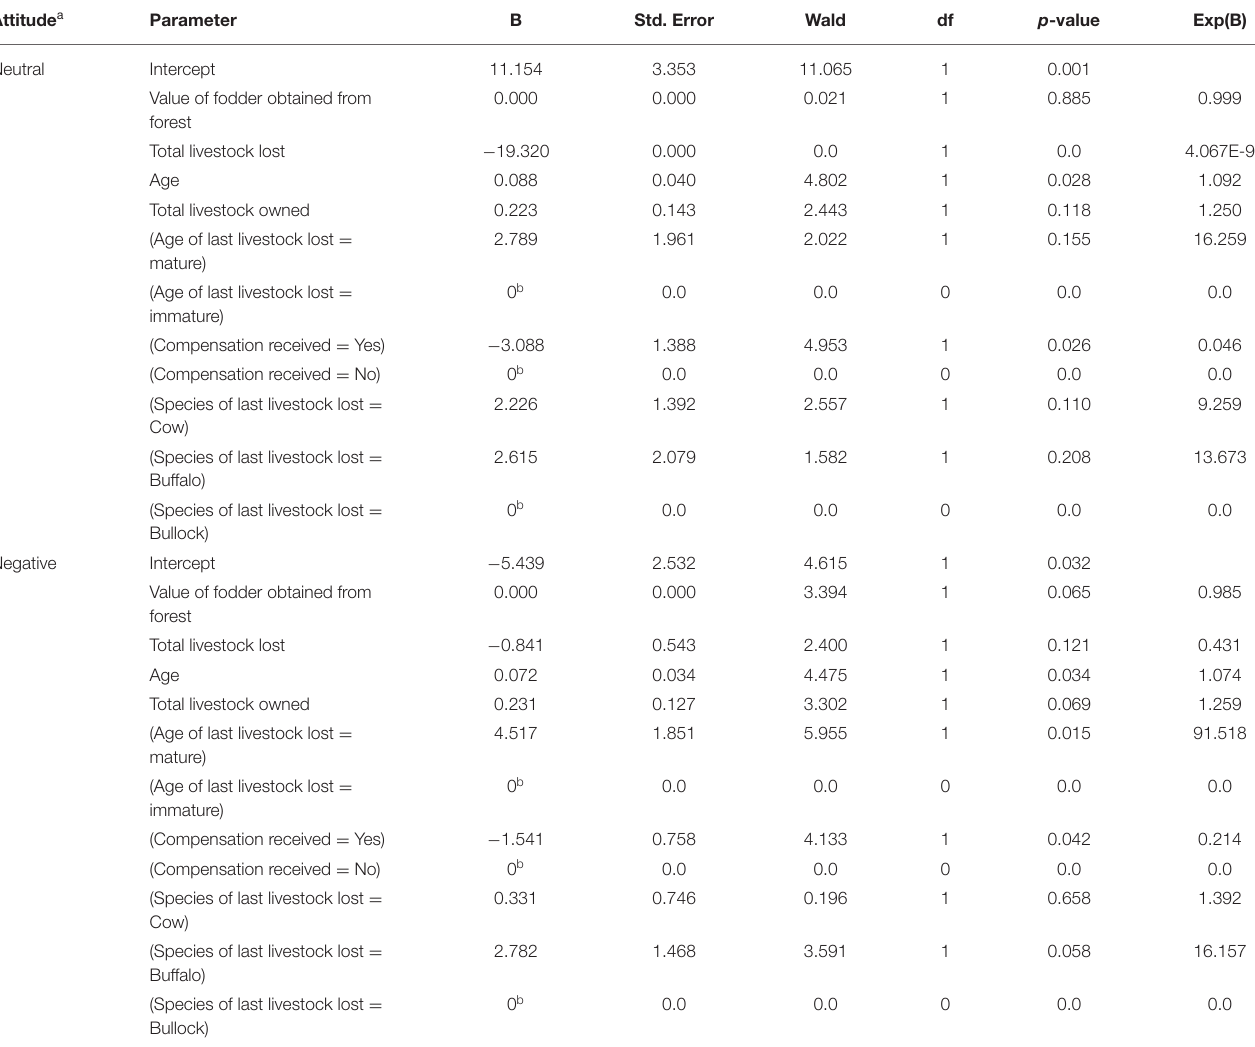
TABLE 4 | Multinomial logistic regression model explaining the attitude of people facing loss, towards tiger in Panna Tiger Reserve: parameter estimates. Attitude a Parameter B Std. Error